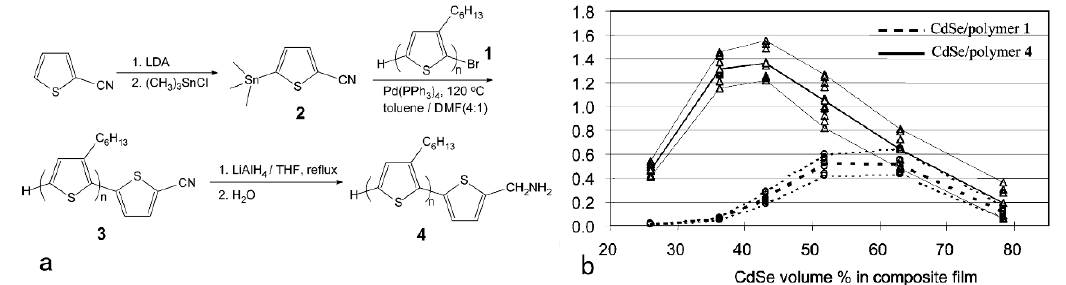
Figure 3. ( a ) Synthesis route for P3HT with amino end-functionality. ( b ) Plots of power conversion efficiency (PCE) versus the volume ratio of CdSe with polymer 4 (solid lines) and polymer 1 (dashed lines) as the donor, respectively. Note the very high reproducibility of the lowest, highest and average performance for numerous duplicating devices. Reproduced with permission from [29], Copyright © 2004, American Chemical Society.